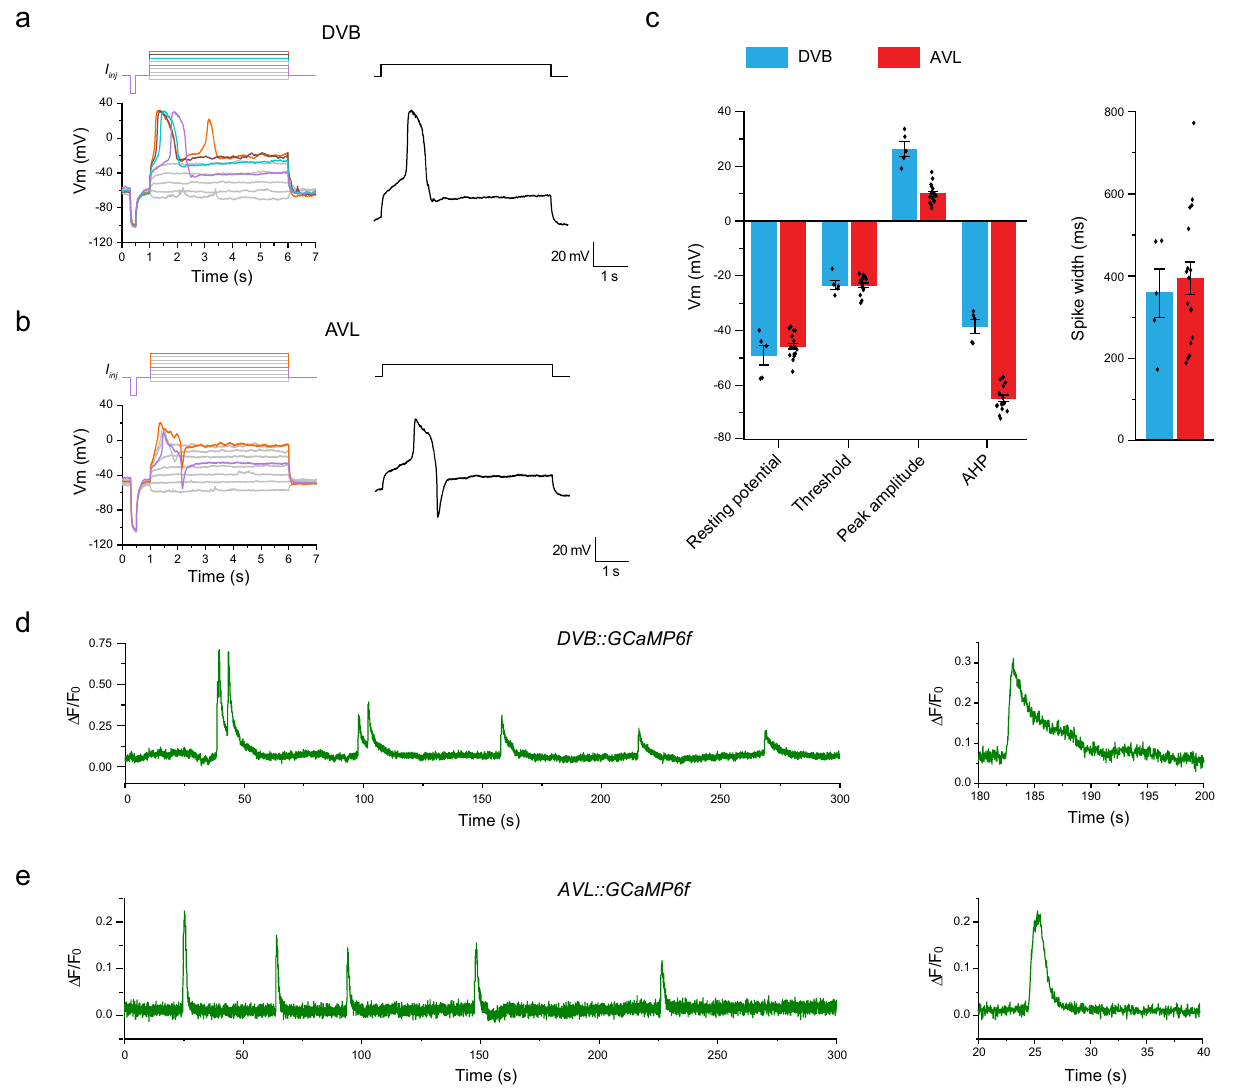
Fig. 1 Enteric neurons AVL and DVB fi re action potentials with distinct kinetics. a , b Representative current-clamp recording traces from DVB and AVL. Top: current-injection stimulation steps (5 s long at 1 pA increment). Left: membrane potential dynamics under color-matched stimulation steps. Right: representative single recording traces with action potentials fi red. c Statistical measurements of resting membrane potential (DVB: − 49.0 ± 3.6 mV; AVL: − 45.7 ± 1.1 mV), threshold (DVB: − 23.4 ± 1.6 mV; AVL: − 23.3 ± 0.8 mV), peak amplitude (DVB: 26.3 ± 2.6 mV; AVL: 9.8 ± 0.8 mV), afterhyperpolarization (AHP) (DVB: − 38.5 ± 2.5 mV; AVL: − 64.8.3 ± 1.2 mV), and half-maximum spike width (DVB: 358.8 ± 59.5 ms; AVL: 394.2 ± 40.0 ms) for DVB ( n = 5) and AVL action potentials ( n = 17) in wild-type animals. The error bar is SEM. d , e Representative calcium imaging traces from the cell bodies of DVB and AVL expressing GCaMP6f. Left: 300 s continuous recording traces. Right: isolated single calcium spikes from the left traces to demonstrate the difference in calcium signal decay. Source data are provided as a Source Data fi